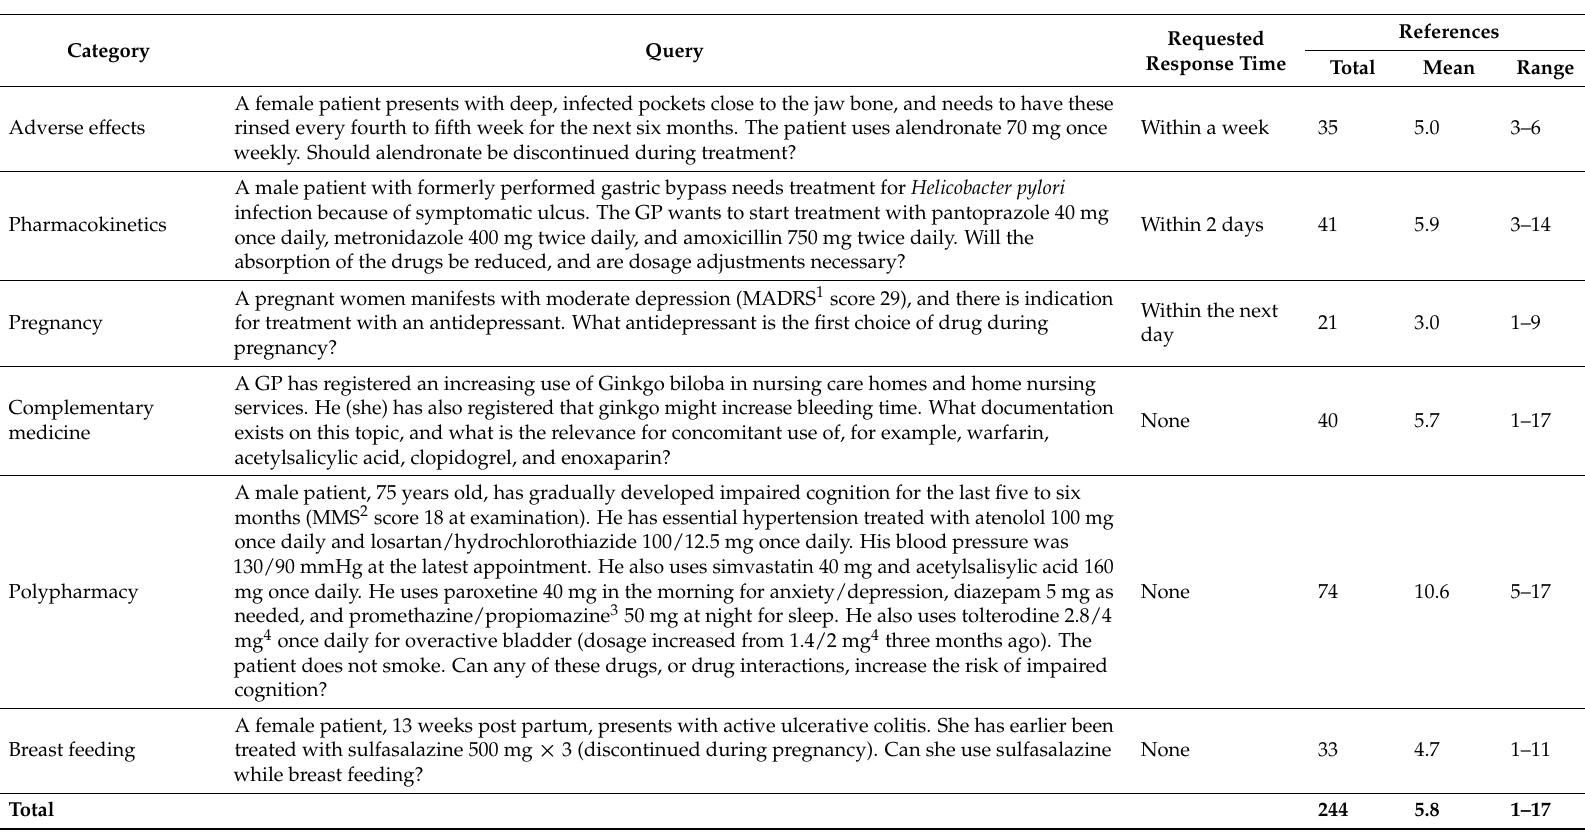
Table 1. Type of query with total, mean, and range of number of references among the seven Scandinavian drug information centres (DICs) participating in the study.